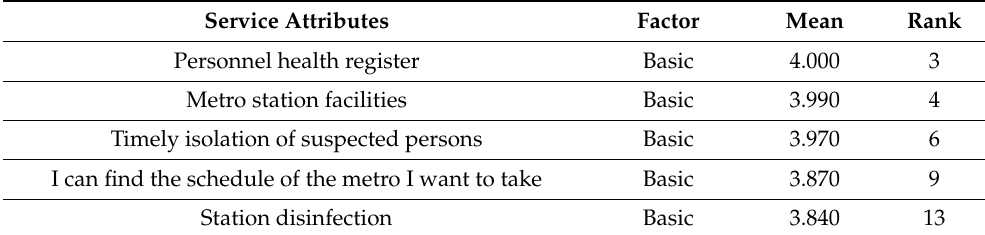
Table 7. Classification and ranking of service